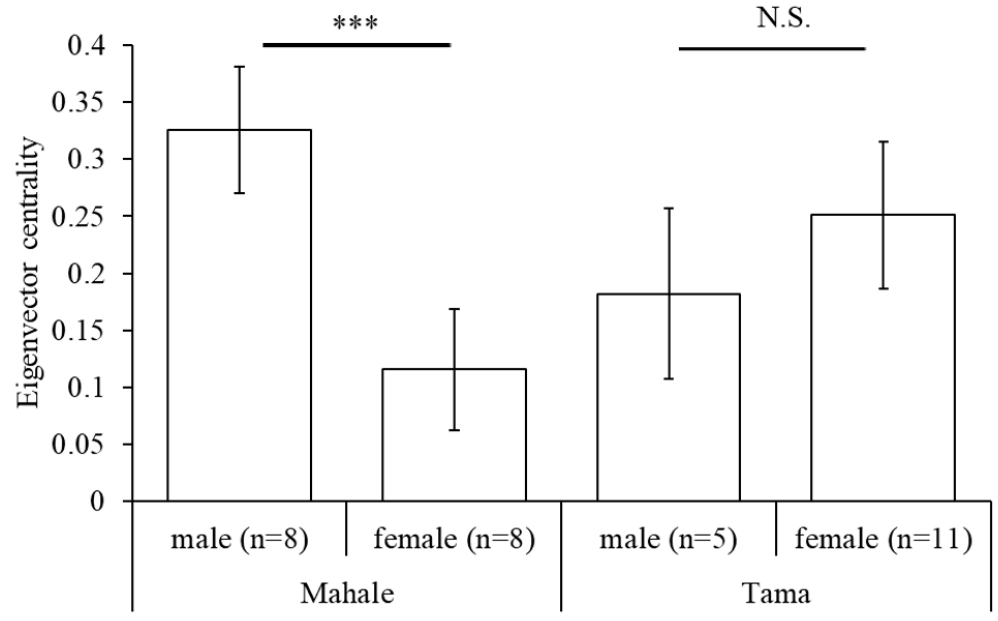
Figure 5. Comparisons of eigenvector centrality between males and females in each group. Error bars indicate standard deviation. *** denotes a significance of p < 0.001, and N.S. denotes a nonsignificant ( p >